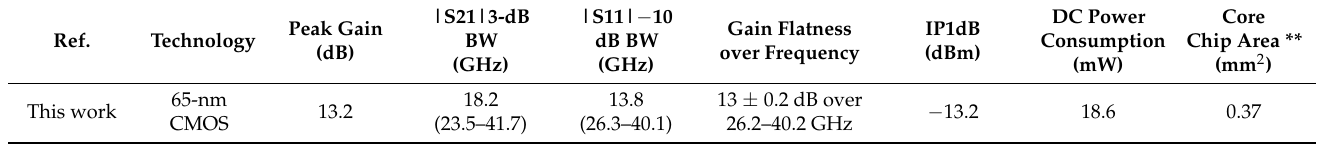
Table 2. Performance comparison with previous CMOS-based Ka-band